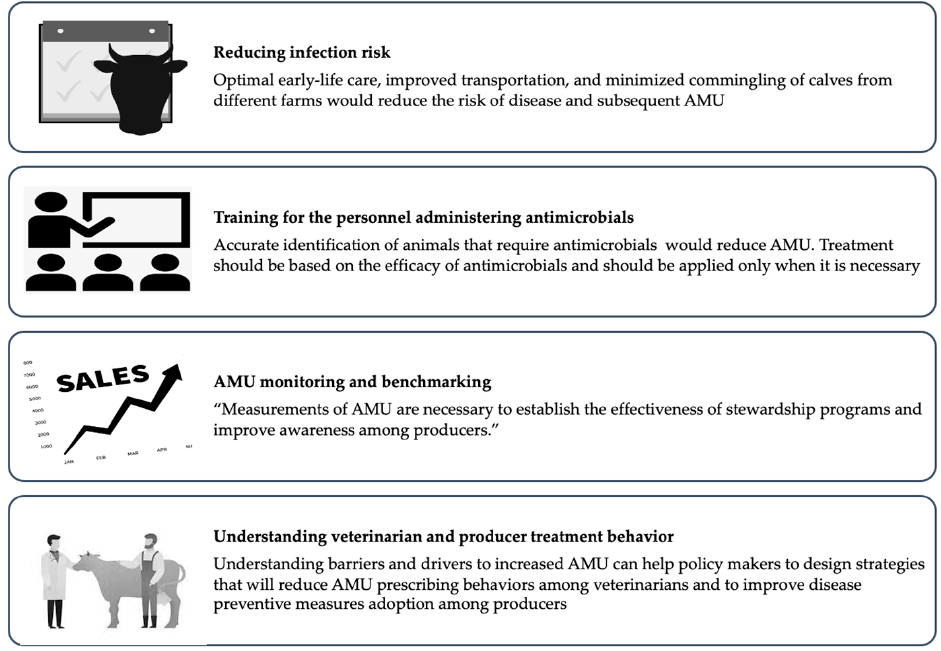
Figure 2. Strategies for reducing antimicrobial use in surplus calf production.